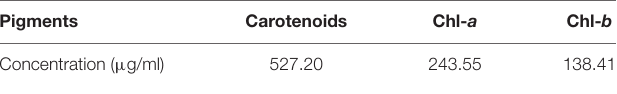
TABLE 1 | Pigment quantification in the T1 crude extract. Pigments